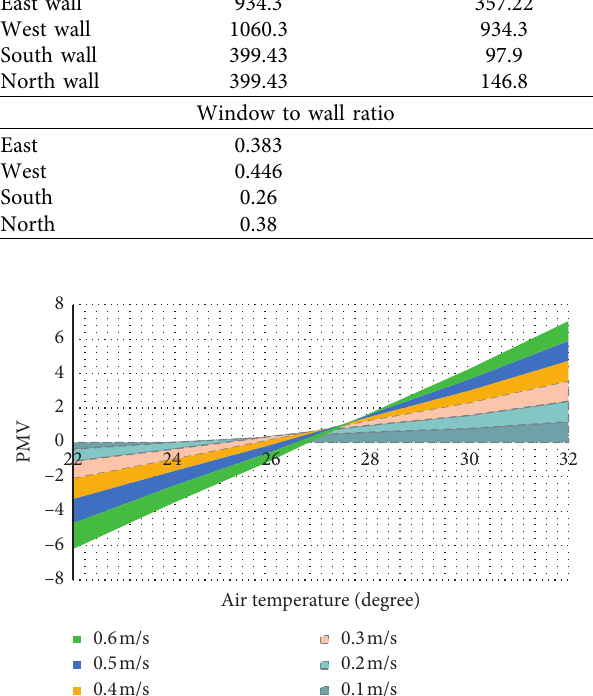
Figure 2: Effect of air temperature on PMV under different wind speeds.